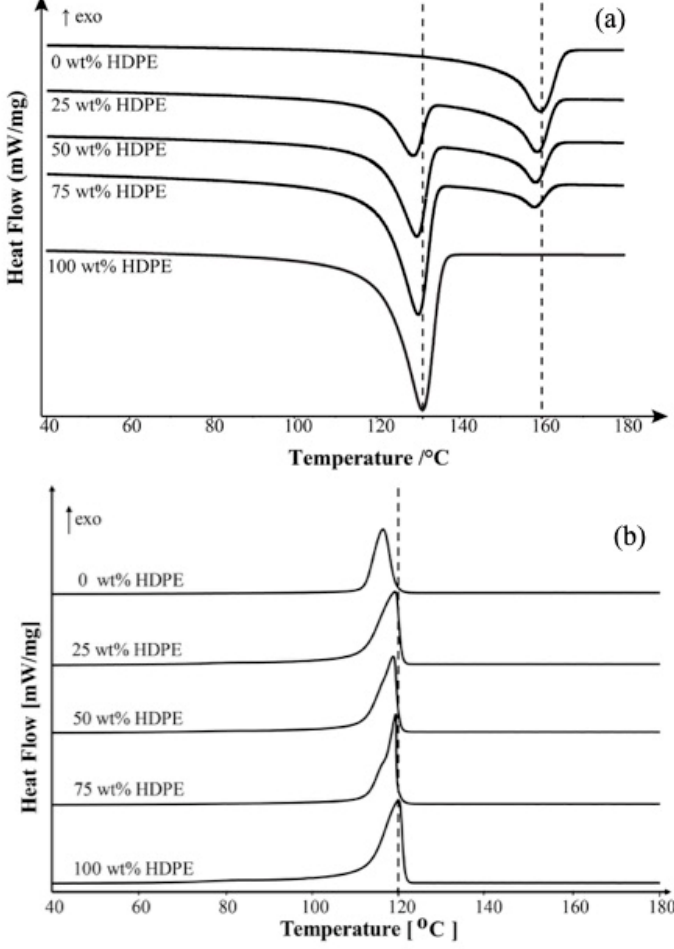
Figure 2. ( a ) Melting temperature ( T m ) from the 2nd heating scan and ( b ) crystallization temperature ( T c ) of PP, high-density polyethylene (HDPE) and their blends at different